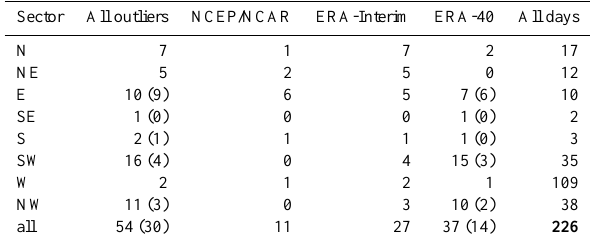
Table 2. Outliers (difference between reanalysis and Prague wind directions more than 45 ◦ ) for all three reanalyses at 10hPa for dif- ferent wind sectors as observed in Prague. “True” outliers (without ERA-40 1998/1999–2001/2002 winter outliers) are shown in brack- ets where their number differs from all